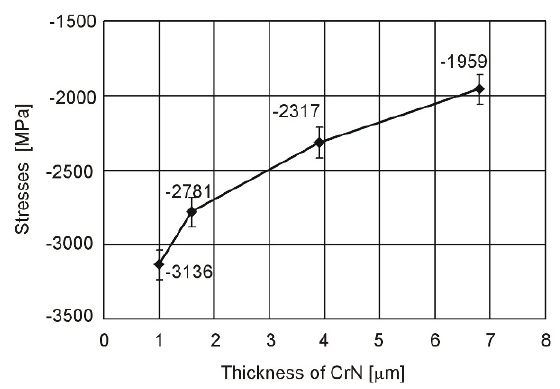
Figure 9. Results of CrN coatings stresses of different thick- ness obtained by means of the arch-vacuum method on EN X38CrMoV5.3 steel substrate with generated nitrided layer including exclusively diffusion zone, carried out with the use of sin 2 ψ